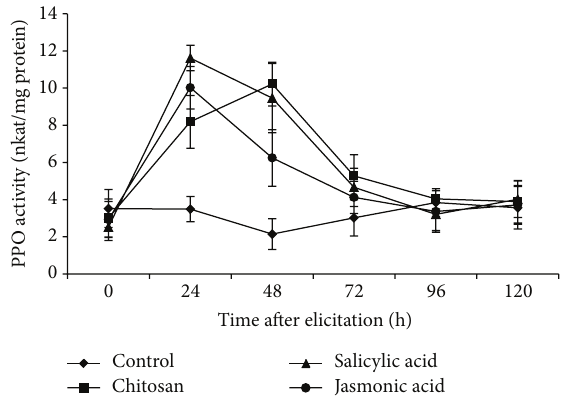
Figure 5: Polyphenol oxidase (PPO) activity (nkat/mg protein) on a time course in elicited and nonelicited (control) roots of tomato. Values are mean ± SD of triplicate analysis.